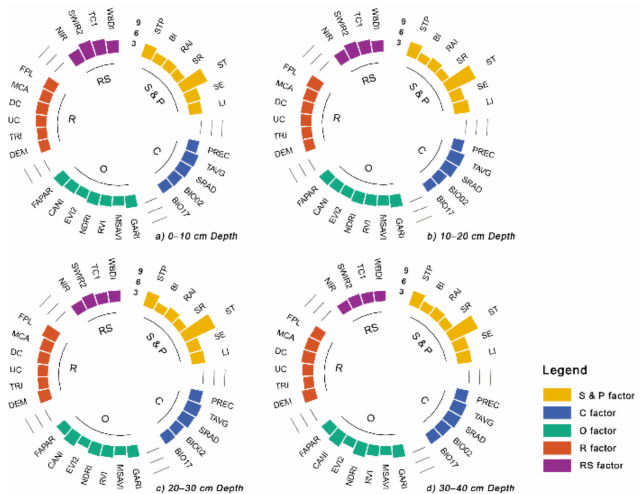
Figure 7. Importance of detailed subfactors when modeling RF, where S and P factor is the soil and parent material factor, C factor is the climate factor, O factor is the organism factor, R is the relief factor and RS is the remote sensing